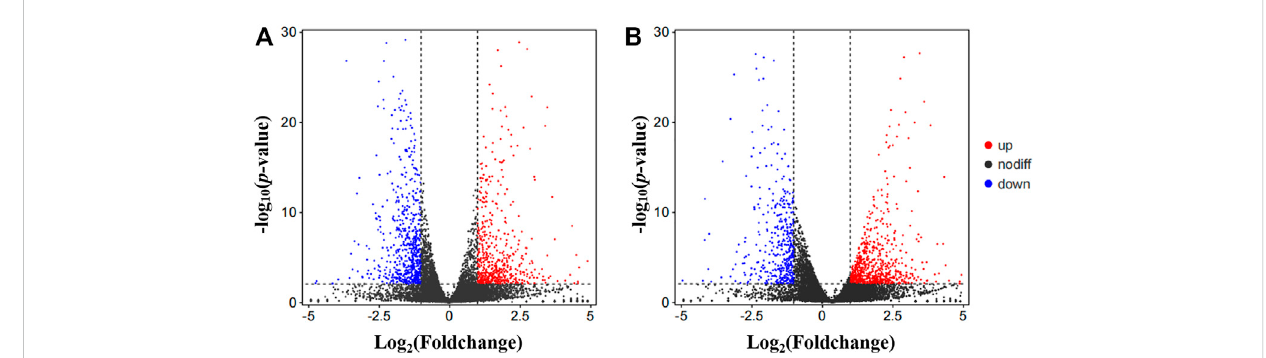
FIGURE 4 Visualized by volcano plot of differentially expression genes (DEGs). (A) Control vs. T24. (B) Control vs. T48. Nodiff: genes without signi fi cant expression difference; Up, Upregulated DEGs; Down, Downregulated DEGs.